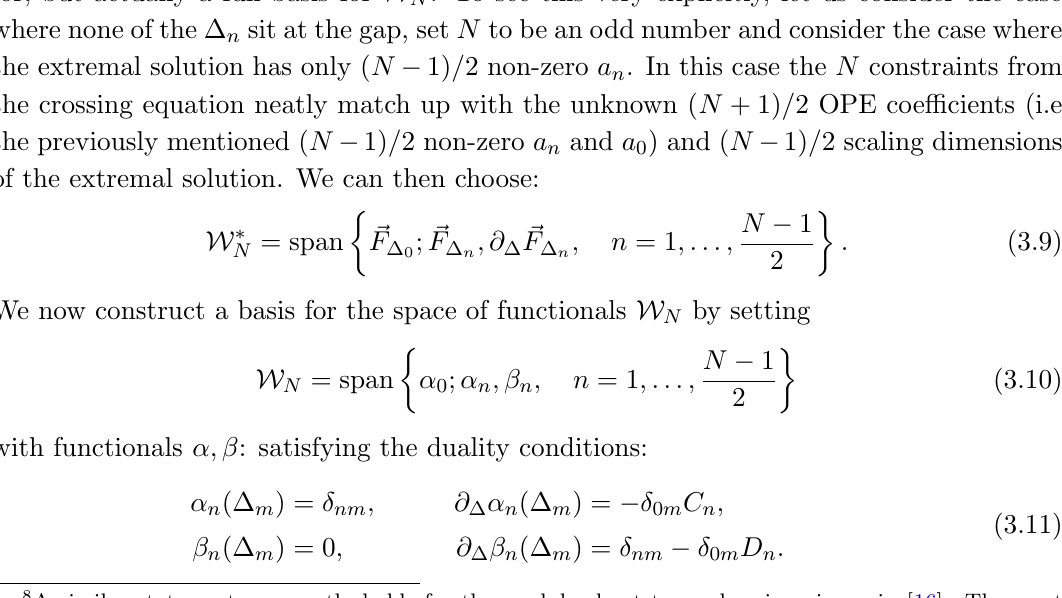
for any choice of (cid:1) g down to where the functional (cid:12)rst becomes 0